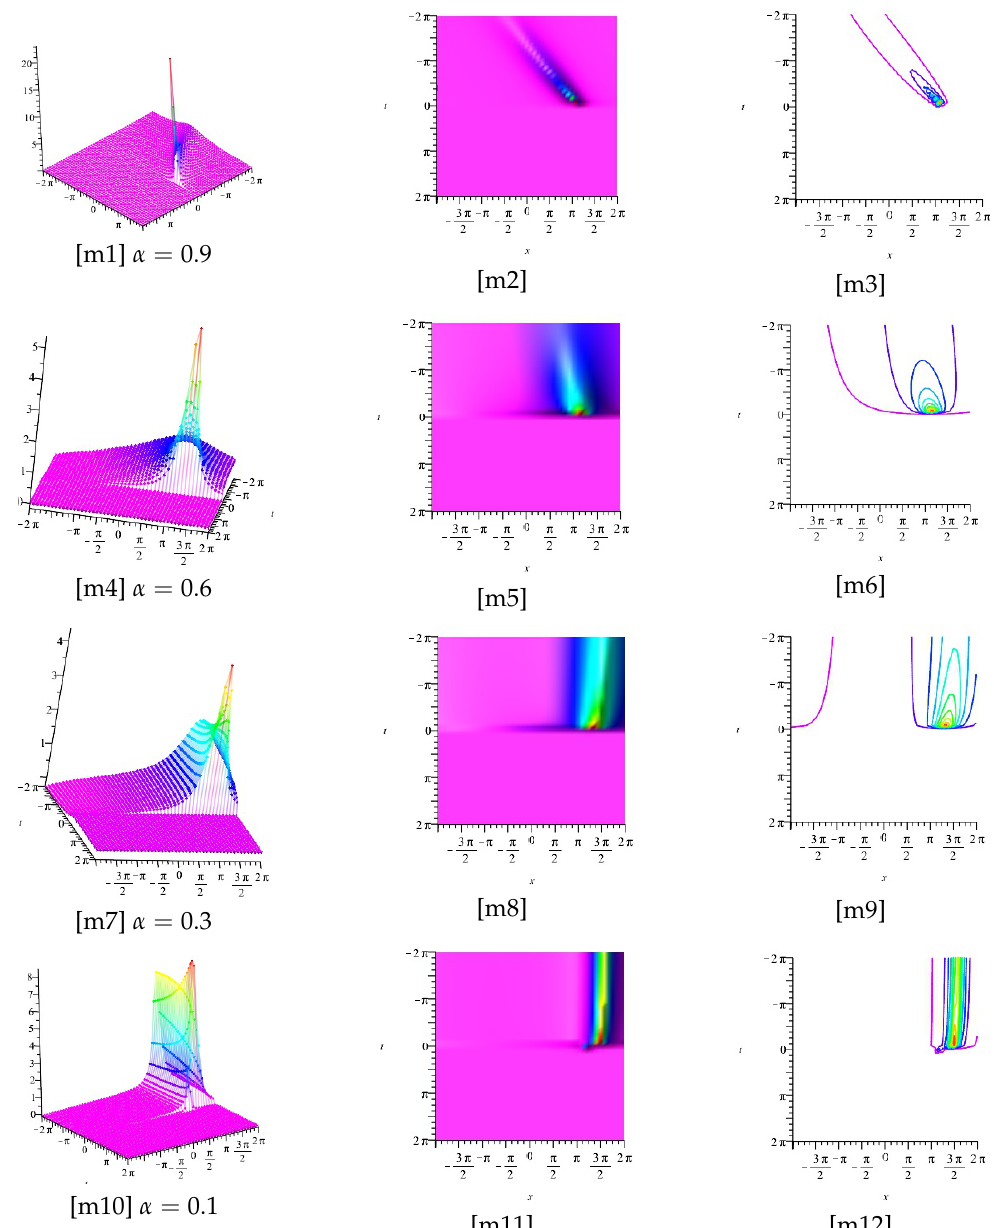
Figure 13. Now, [m1], [m4], [m7], and [m10] display the plots of the real part of Equation (38), for λη > 0, and [m2], [m5], [m8], and [m11], as well as [m3], [m6], [m9], and [m12], display the z -axis orientation and the contour plot,